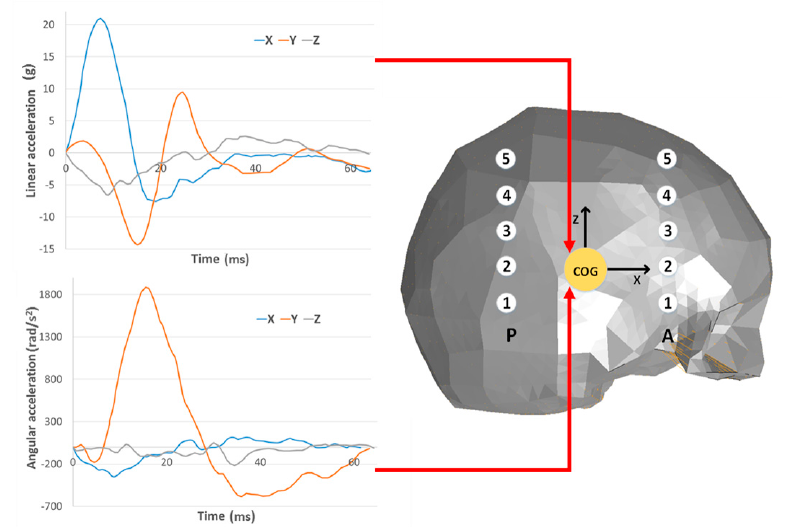
Figure 2. Boundary conditions for Hardy et al. [35] with marker numbers for the frontal (A) and rear columns (P).